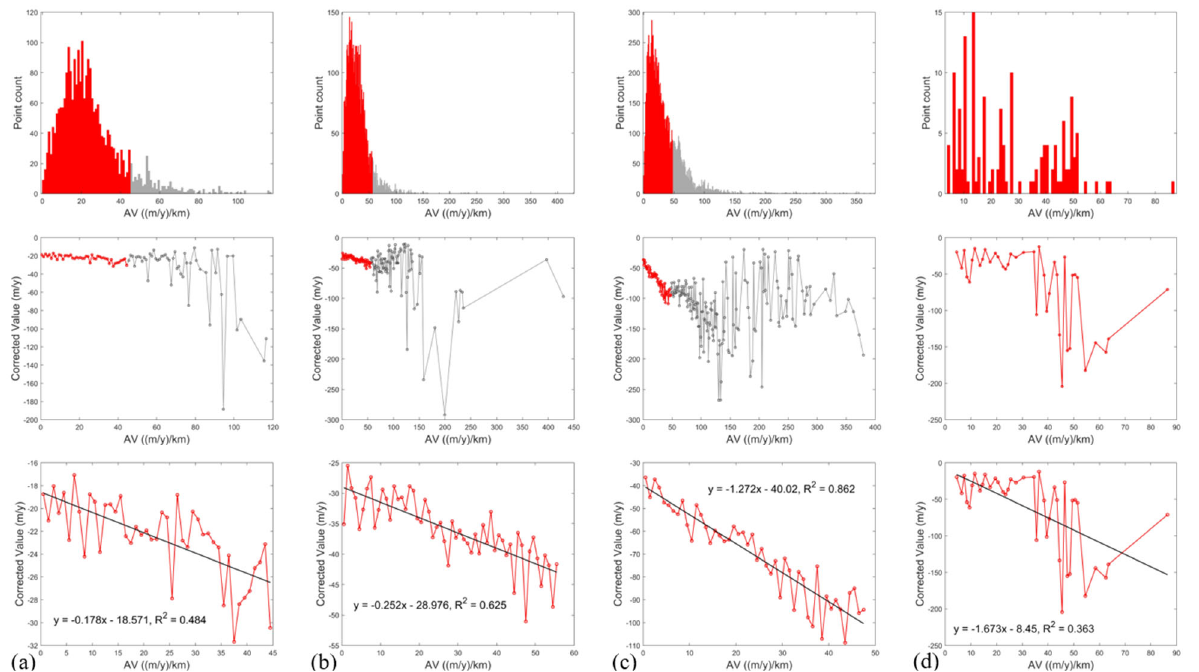
Figure 6 . The relationship between corrected values and AV (a) without GL0’25 km buffer and in inland (Sub-region 1), (b) within GL0’25 km buffer and in inland (Sub-region 2), (c) within GL0’25 km buffer and in ice shelf (Sub-region 3), (d) without GL0’25 km buffer and in ice shelf (Sub-region 4).